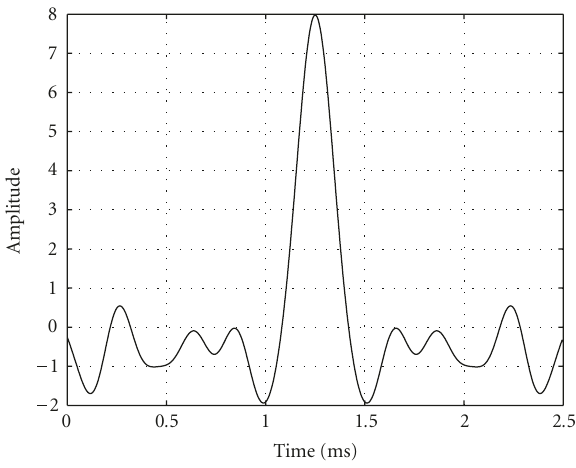
Figure 6: The estimated P300 sources using Infomax. The simu- lated P300 is slightly more distorted than that obtained by CBSS and achieves a higher mean square error.